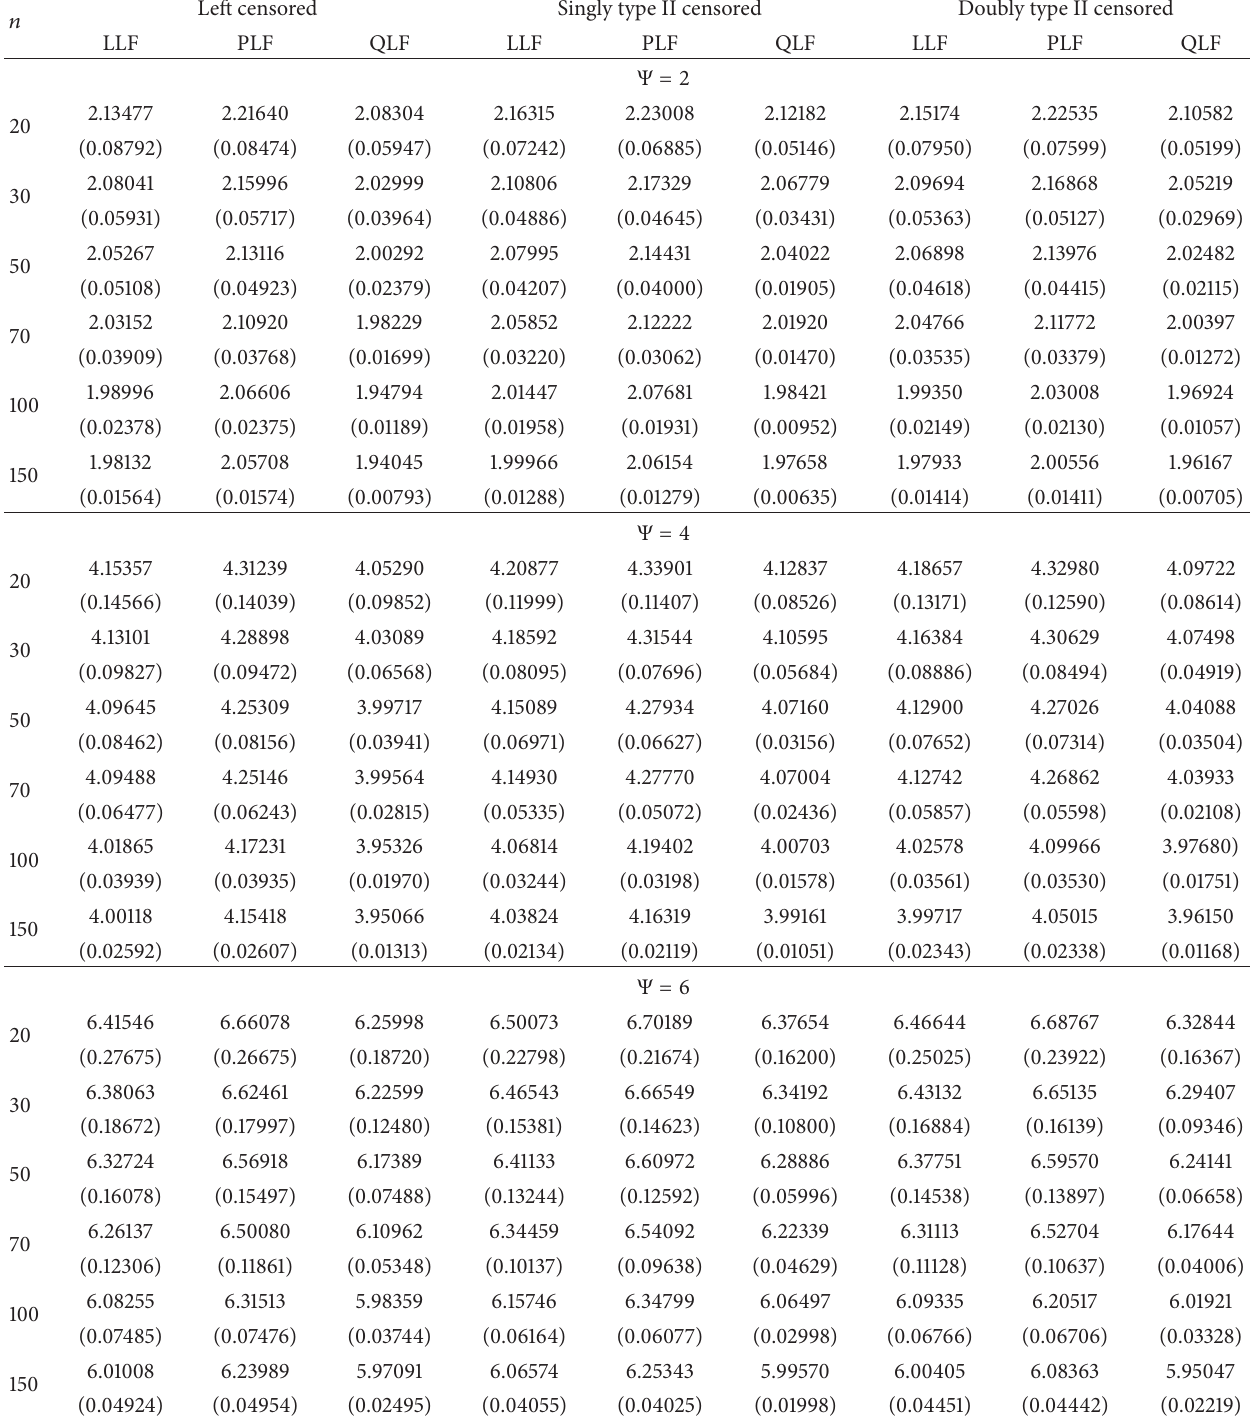
Table 3: Bayes estimators and posterior risks under exponential